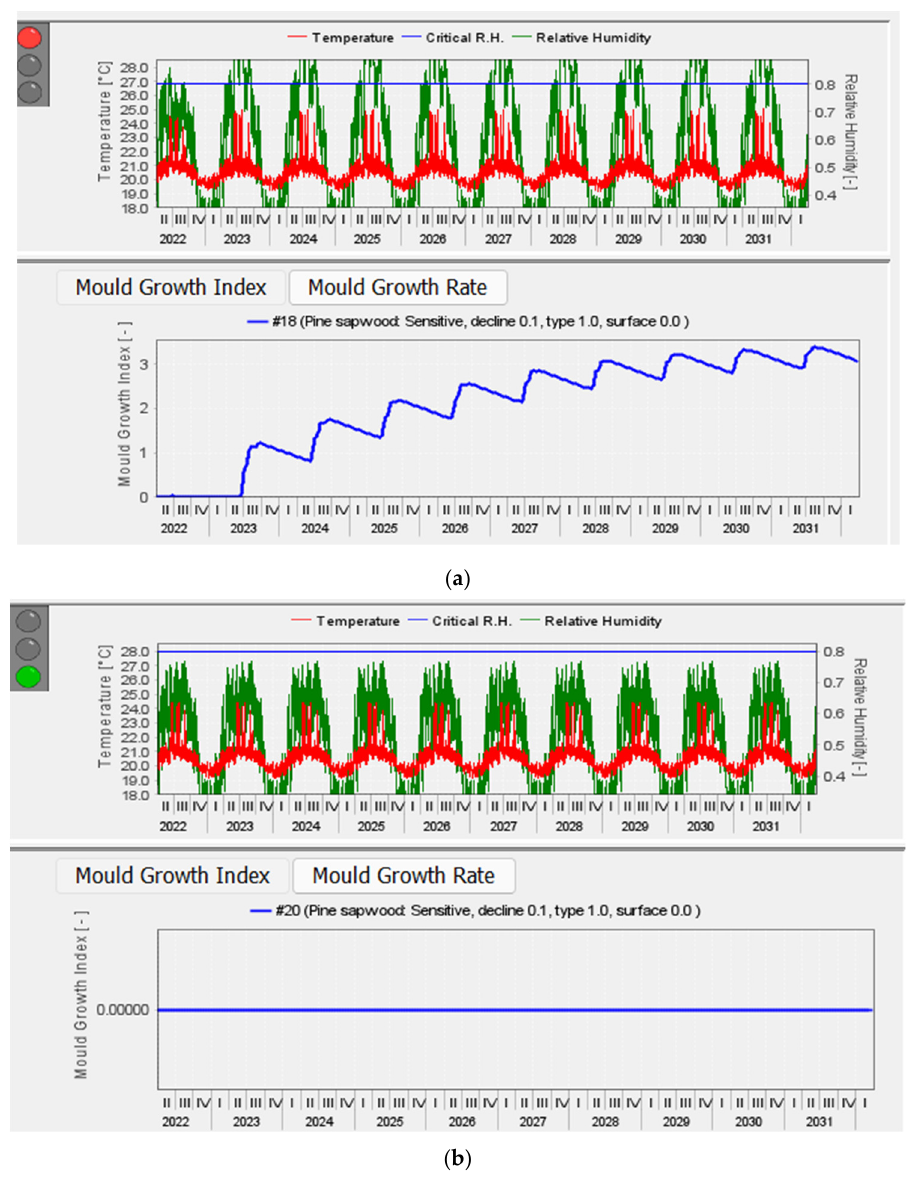
Figure 22. ( a ): Mould Growth Index graph for the wall assembly with single point resistivity value of membrane C in north orientation of cold Holzkirchen climate; ( b ): Mould Growth Index graph for the wall assembly with multipoint resistivity value of membrane C in north orientation of cold Holzkirchen climate.